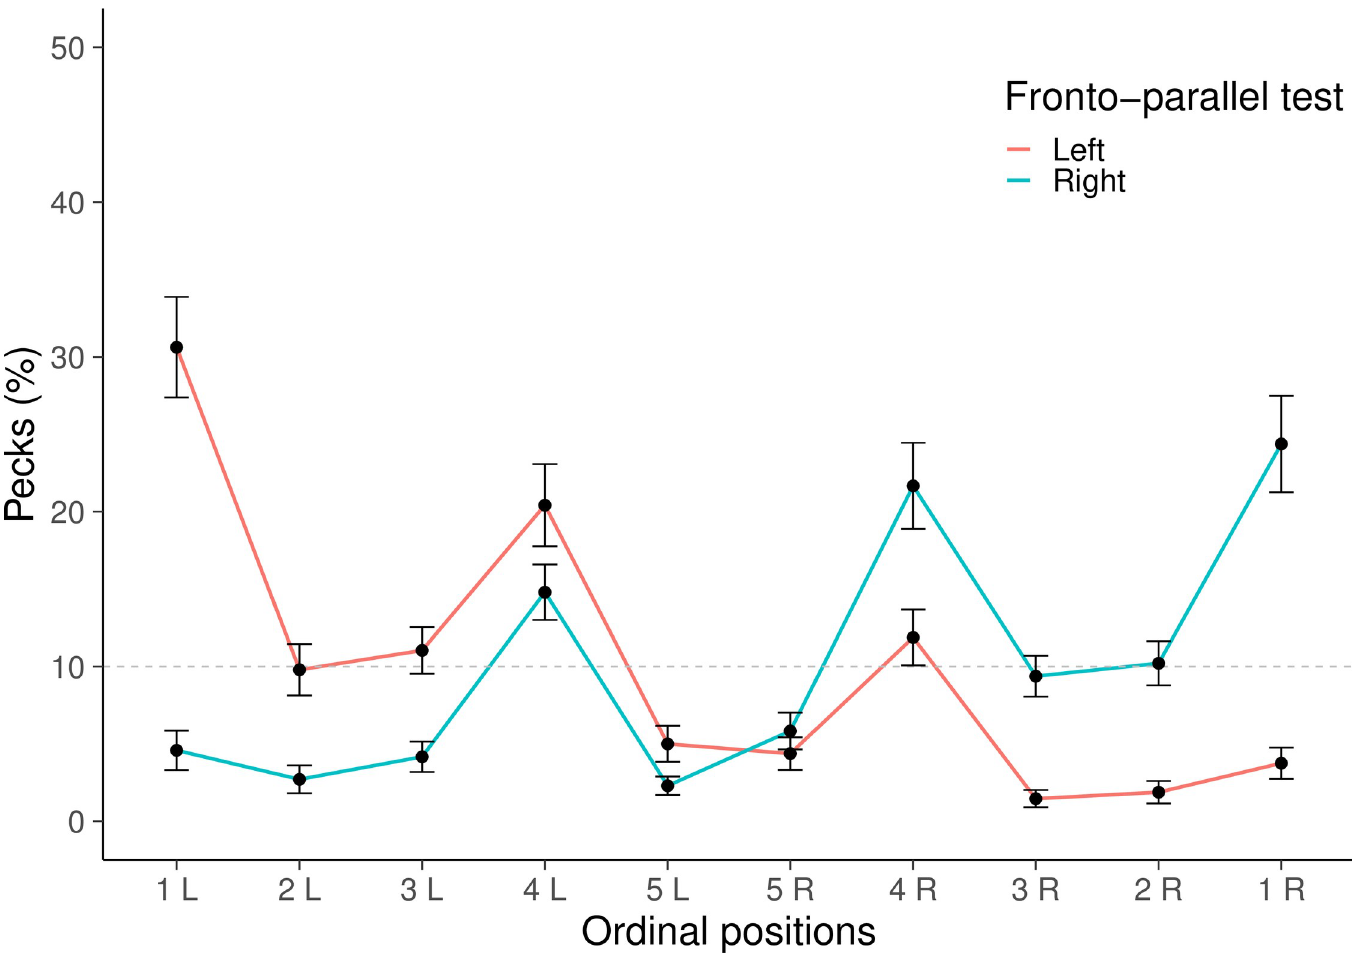
Fig 2. Accuracy in the monocular fronto-parallel tests. The graph represents the mean percentage + SE of choices for each position; the dotted line represents chance level (y = 10). Results of the left monocular fronto-parallel test, in red; results of the right monocular fronto-parallel test, in blue.